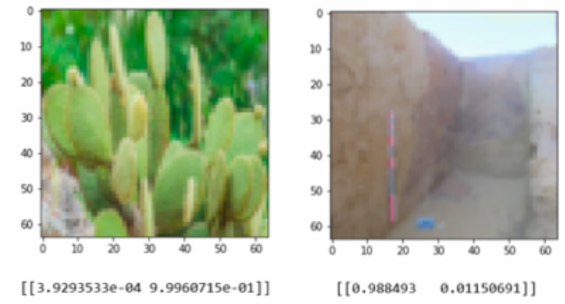
Figure 8 - Results provided by our CNN on a non-silo image (cacti) and a silo from an excavation (values correspond to the probability of belonging to the silo